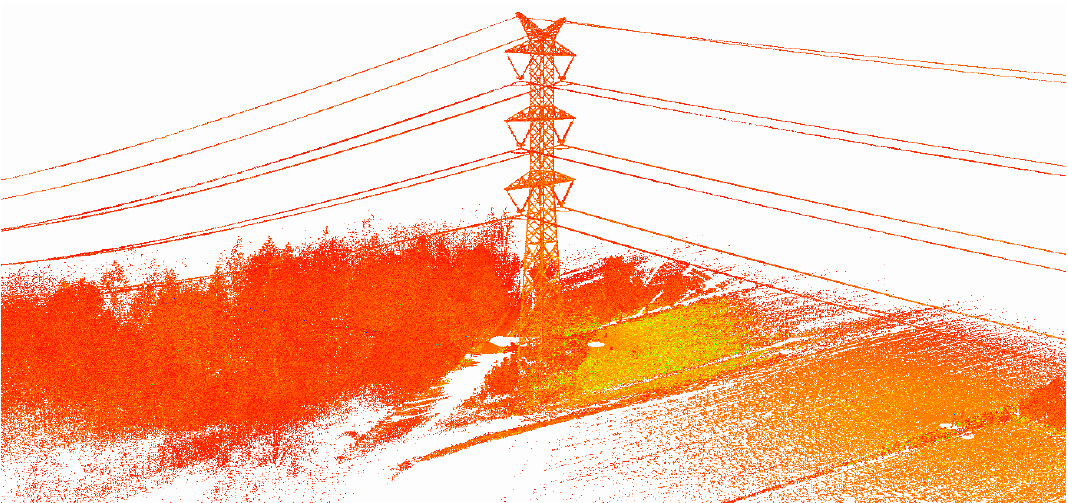
Figure 15. High-resolution terrestrial laser scanning (TLS) point cloud of a high-voltage power line (Dataset IV). The color of the points is determined by the intensity (the strength of the reflected laser beam).